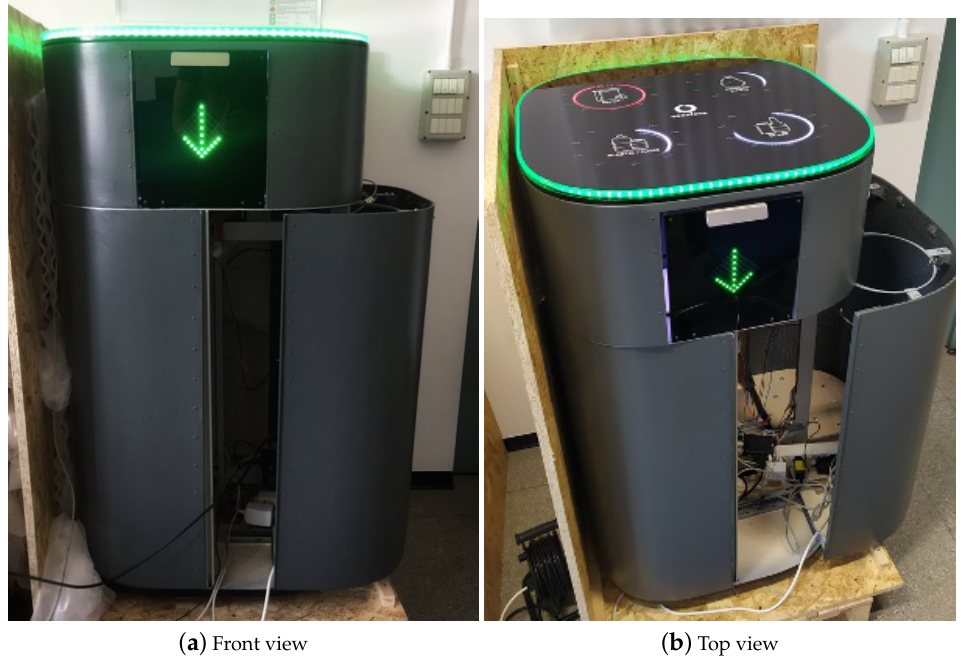
Figure 4. Smart waste bin: realized prototype The top part of the SWB is composed of a plastic surface that protects four circular LEDs indicators and a LED string, which are used as visual feedback for the user. The surface is fabricated starting from an anti-scratch piece of semi-transparent rigid plastic, which is later processed with a laser cutting machine and then engraved to make the LEDs visible. The four circular LEDs on the top are used to indicate the fill levels of each bag, respectively, in white from 0% to 99% and in red when the 100% is reached. The LED string contouring the top part is again used to signal the operational status of the bin with the same colour code of the front LED matrix: static green indicating that the SWB is ready